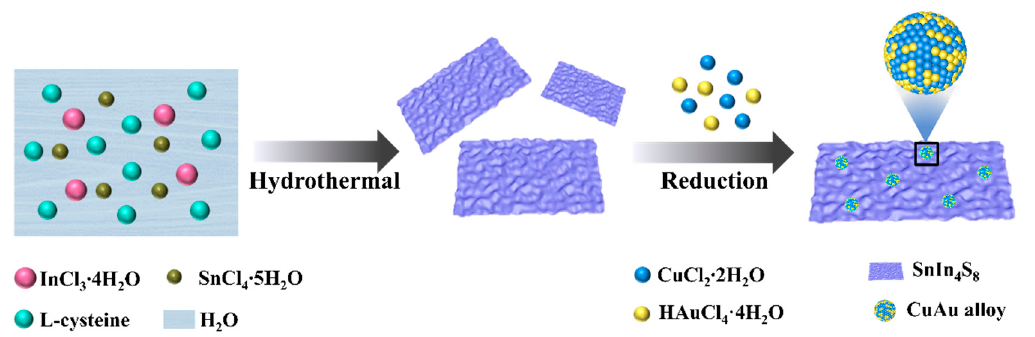
Figure 1. Schematic illustration for the synthetic process of Cu 10 Au 1 -SnIn 4 S 8 .